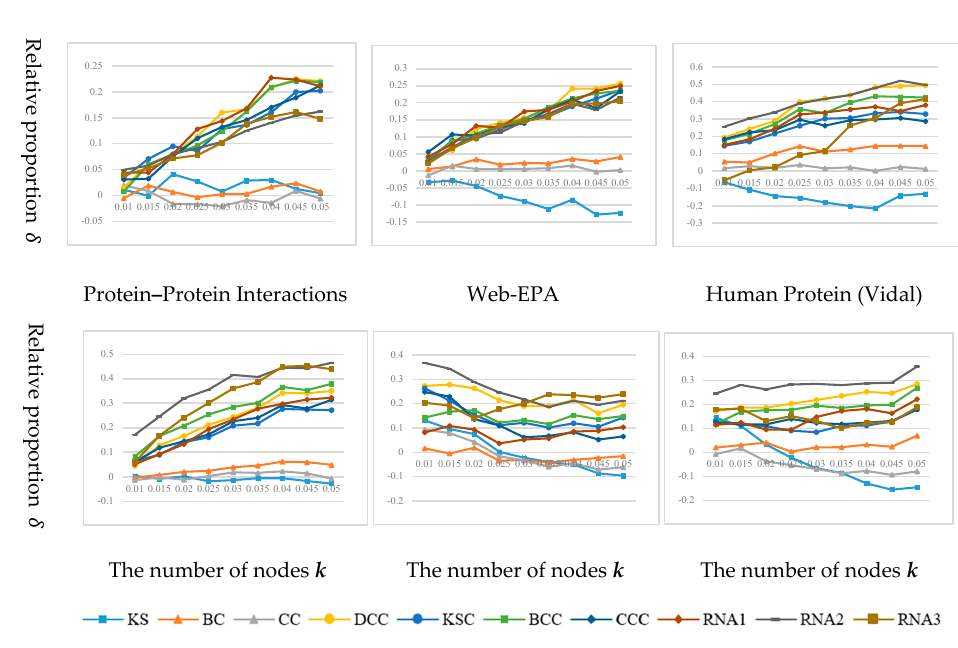
Figure 10. In the single-contact SIR model, the relationship between δ and k with β = 0.2 .